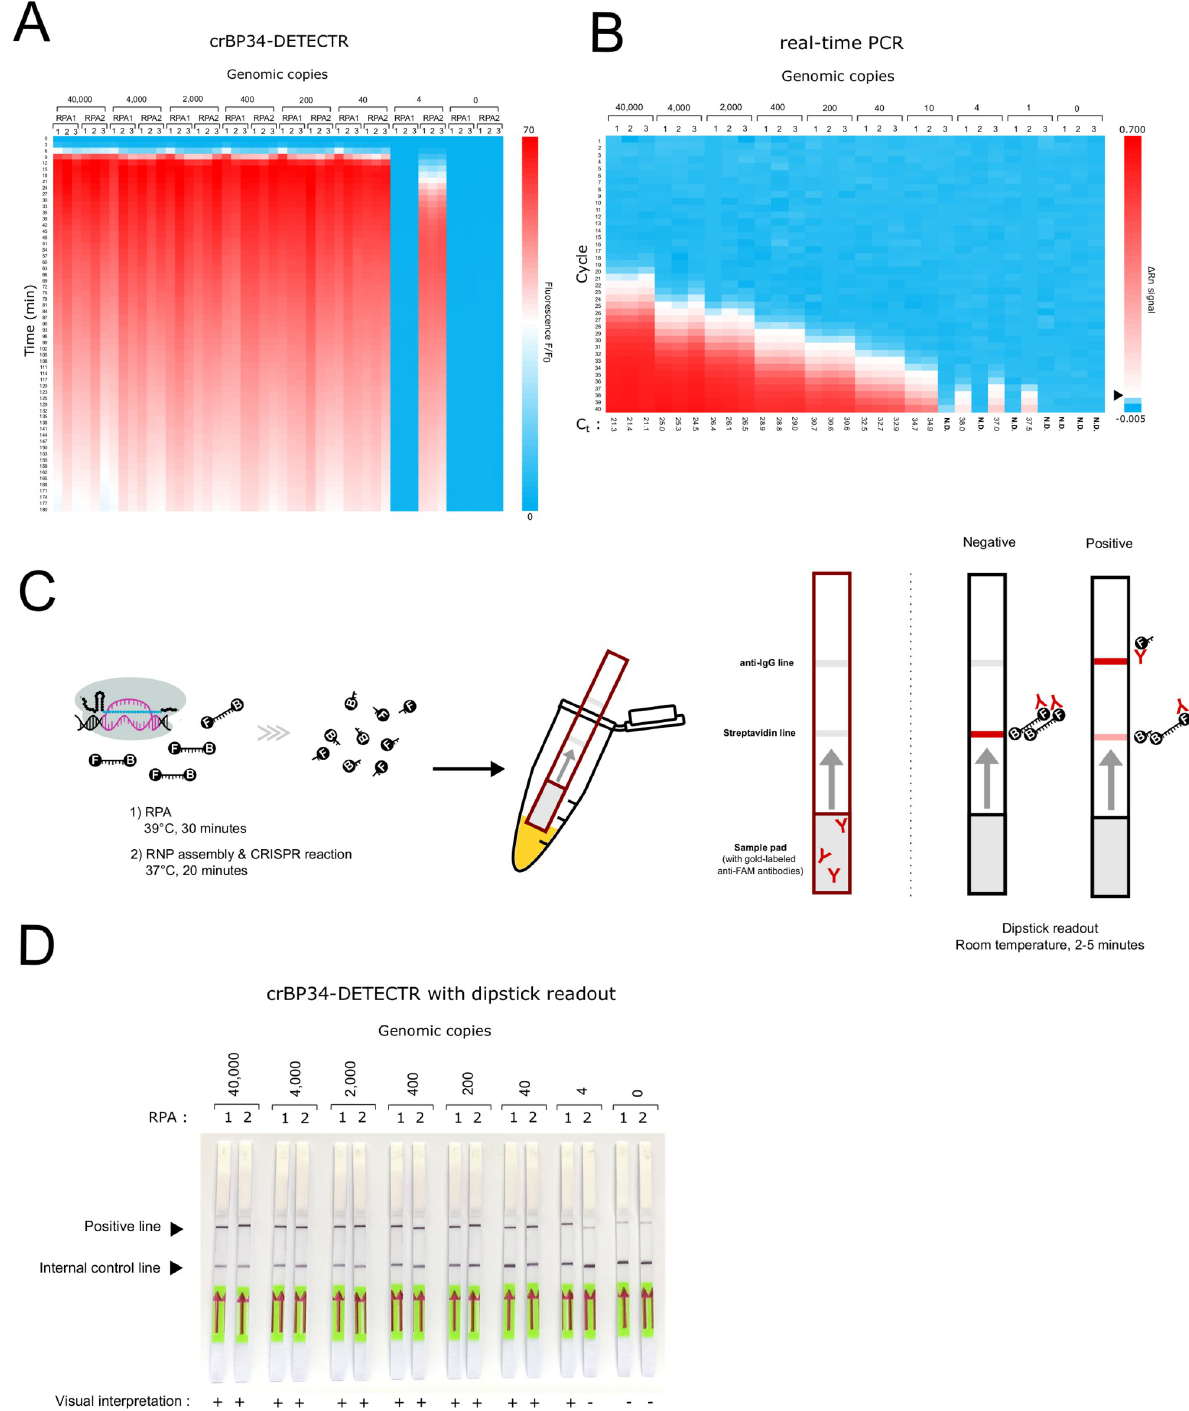
Fig 3. crBP34-DETECTR shows comparable sensitivity to real-time PCR. (A) A heatmap showing fluorescent signals generated by crBP34-DETECTR assay. Known copy numbers of B . pseudomallei genomic DNA ranging from 40,000–0 copies were used in 50- μ l RPA reactions, of which 15 μ l were used in 100- μ l CRISPR reactions. Fluorescent signals were collected at three-minute intervals. The heatmap denotes fluorescence at indicated times compared to fluorescence at 0 minutes (F/F 0 ). For each copy number, two independent RPA reactions were performed; each was subjected to three replicates of CRISPR reactions (total of six CRISPR reactions). A scale bar is shown on the right. (B) A heatmap showing fluorescent signals generated by real-time PCR assay. Known copy numbers of B . pseudomallei genomic DNA ranging from 40,000–0 copies were used in 20- μ l PCR reactions. The heatmap denotes fluorescent signals ( Δ Rn) as a function of the PCR cycle. Datasets from three replicates are